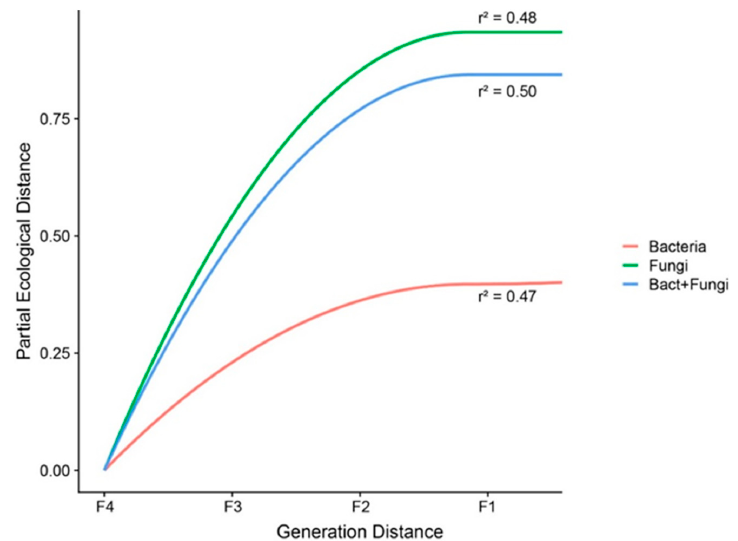
Figure 5. Increasing community dissimilarity of the bacterial (red), fungal (green) and total